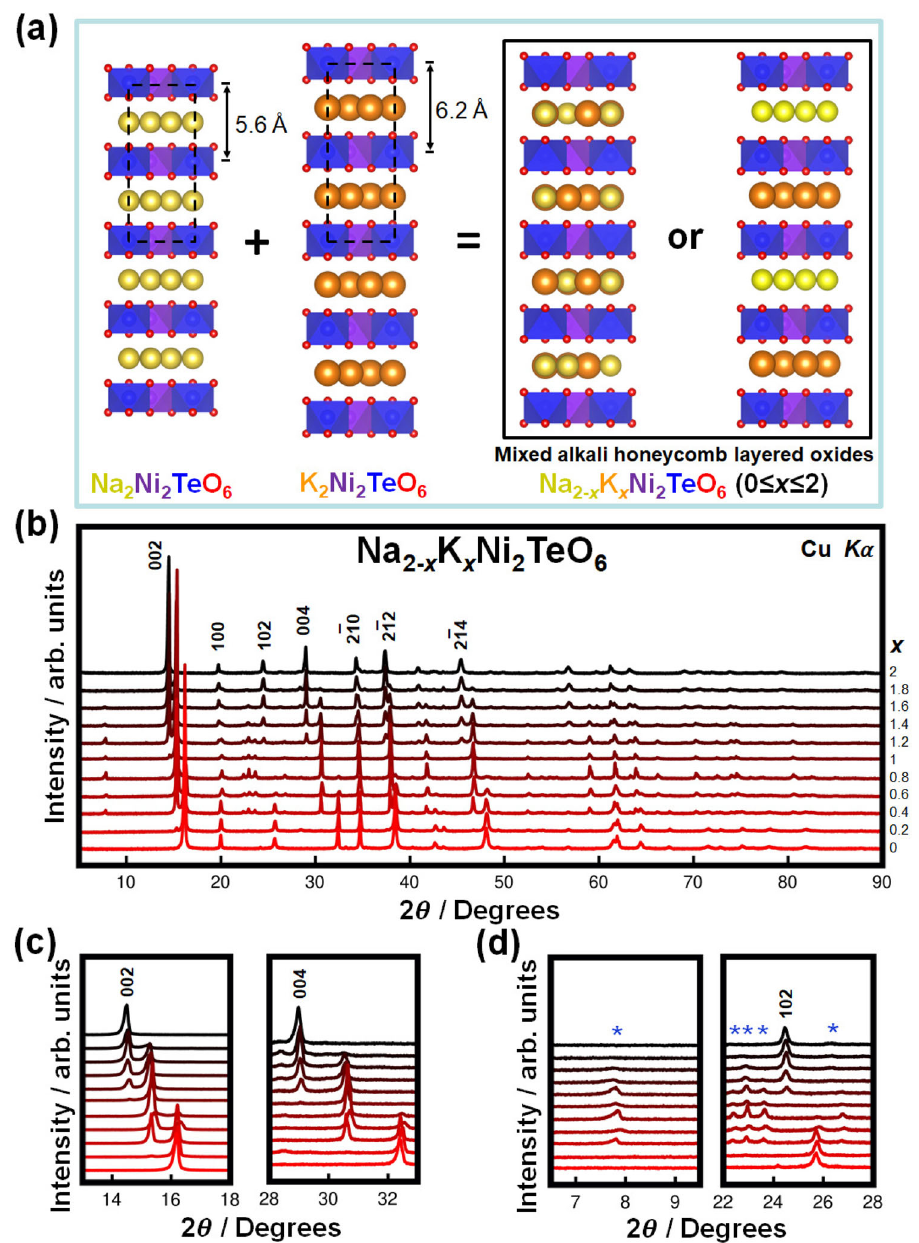
Fig. 1 Structural characterisation of Na 2- x K x Ni 2 TeO 6 (0 ≤ x ≤ 2). a Schematic illustration of possible structural models in mixed-alkali atom honeycomb layered oxides adopting the composition Na 2- x K x Ni 2 TeO 6 (0 ≤ x ≤ 2). In the isostructural A 2 Ni 2 TeO 6 ( A = Na, K) compounds, Na atoms (in yellow) or K atoms (in orange) are sandwiched between layers or slabs consisting exclusively of TeO 6 (blue) and NiO 6 (purple) octahedra. Black dashed lines denote the unit cell. Owing to the larger Shannon – Prewitt ionic radius of K + (1.38 Å) compared to Na + (1.02 Å), the interlayer distance of K 2 Ni 2 TeO 6 is signi fi cantly larger than that of Na 2 Ni 2 TeO 6 . Various reasonable structural models can be hypothesised for the new series of compounds adopting the composition Na 2- x K x Ni 2 TeO 6 (0 ≤ x ≤ 2). Here, models where Na and K atoms are either mixed within the same layers or separated into different layers are shown. b XRD patterns of as-synthesised Na 2- x K x Ni 2 TeO 6 (0 ≤ x ≤ 2), showing a stepwise shift of Bragg peaks towards lower diffraction angles with the substitution of Na with K. Bragg peaks for K 2 Ni 2 TeO 6 that are indexed in the hexagonal P 6 3 / mcm space group are shown in black. Results of the elemental composition analyses of the prime intermediate compositions are furnished in the Supplementary Information (Supplementary Table 1 and Supplementary Figs. 2 – 8). c A stepwise shift of the 002 and 004 Bragg peaks that clearly hallmark the increase in the interlayer distance with K atom substitution. The three distinct peak positions correspond to three phases with different interlayer distances (along the c -axis), with the intermediate peak position signifying the formation of a new phase that is different from the end members Na 2 Ni 2 TeO 6 and K 2 Ni 2 TeO 6 . d Emergence of new Bragg peaks in the intermediate compositions (0 ≤ x ≤ 2), which are not allowed in the P 6 3 / mcm hexagonal space group. These new peaks are marked by asterisks and are indicative of a symmetry change that may entail the formation of superstructures.